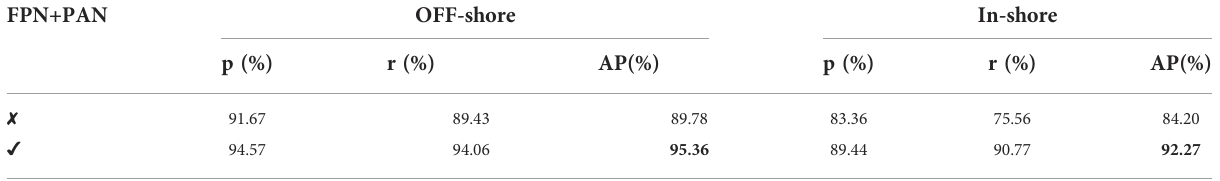
TABLE 7 The ablation study of our proposed model removal and installation the FPN+PAN module on the SSDD dataset. FPN+PAN